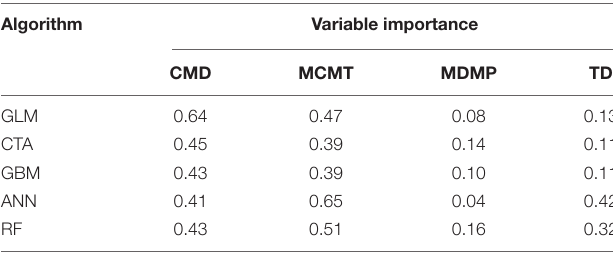
TABLE 2 | Variable importance by algorithm of the climatic predictor variables used in the OccurenceSDM. Algorithm